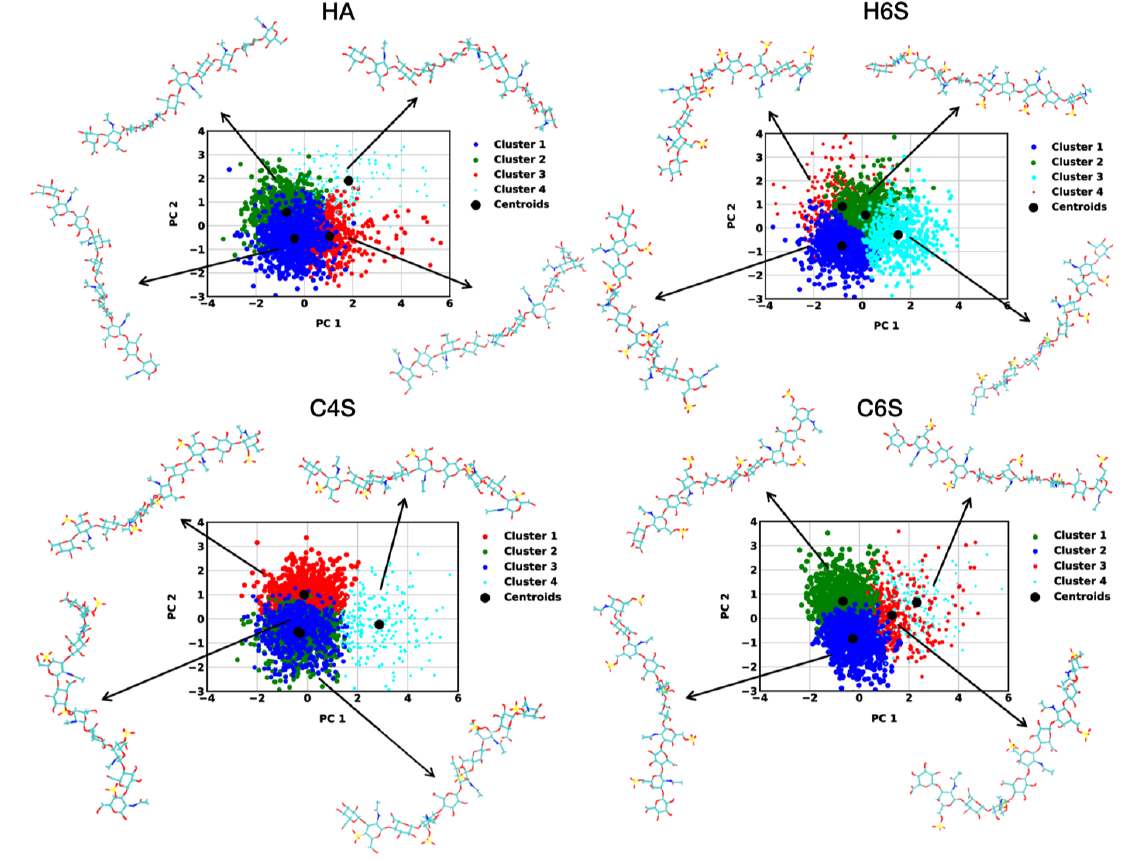
Figure 8. Projection of the MD trajectories obtained at 150 mM NaCl onto the first two principal components for the different GAGs (see the label above each panel). The conformations are segregated into four clusters, which are represented by different colors. Structures corresponding to the centroid structures are